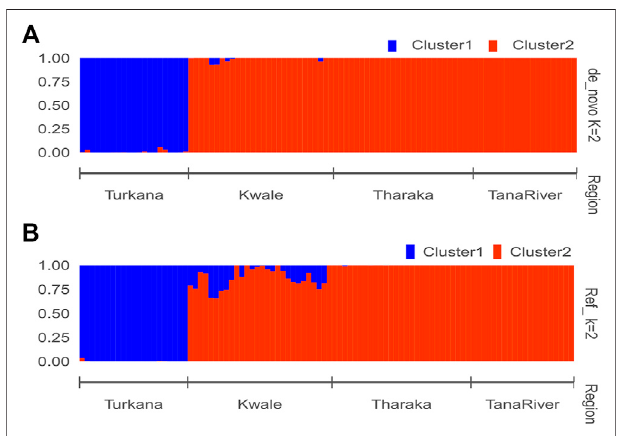
FIGURE 2 | STRUCTURE bar plot of admixture model population assignment of 96 Hyphaene compressa accessions from Kenya based on 2,096 SNPs for the de_novo assembly (A) and 23,416 SNPs based on reference assembly (B) . The accessions are divided into two clusters. A combination of different colors represents admixed